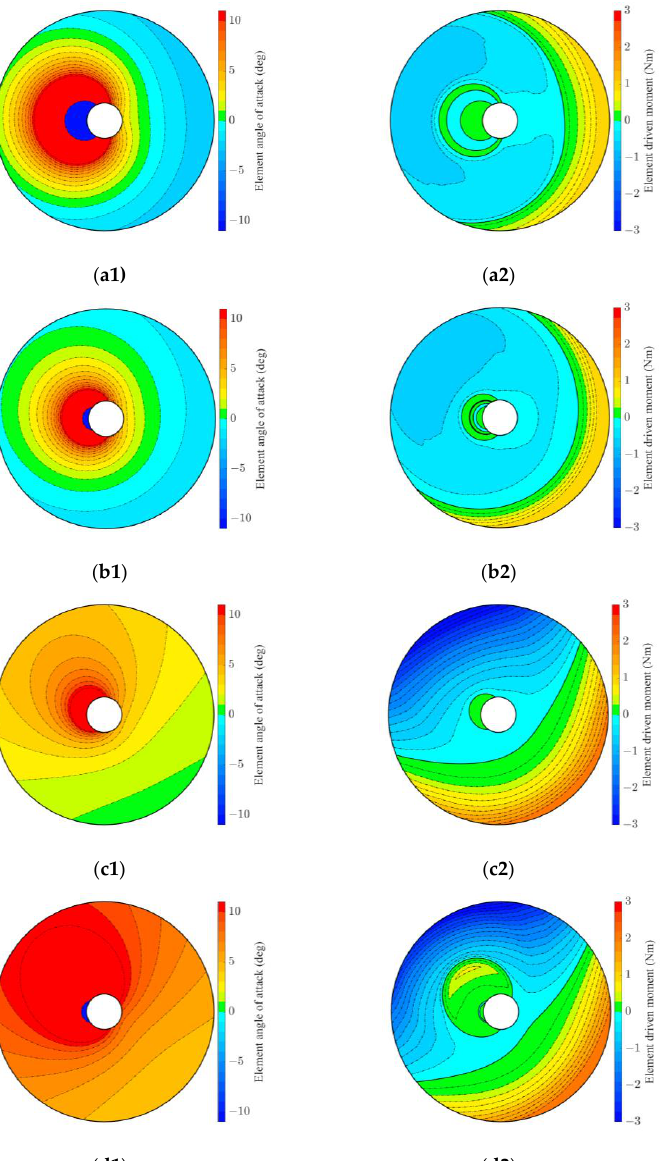
Figure 8. Blade element angle of attack and driven moment distribution of the rotor disk at V x = 10 m/s, θ = 15 deg: ( a1 ) element angle of attack of θ 0 = − 7 deg; ( a2 ) element driven moment of θ 0 = − 7 deg; ( b1 ) element angle of attack of θ 0 = − 4 deg; ( b2 ) element driven moment of θ 0 = − 4 deg; ( c1 ) element angle of attack of θ 0 = 1 deg; ( c2 ) element driven moment of θ 0 = 1 deg; ( d1 ) element angle of attack of θ 0 = 5 deg; ( d2 ) element driven moment of θ 0 = 5